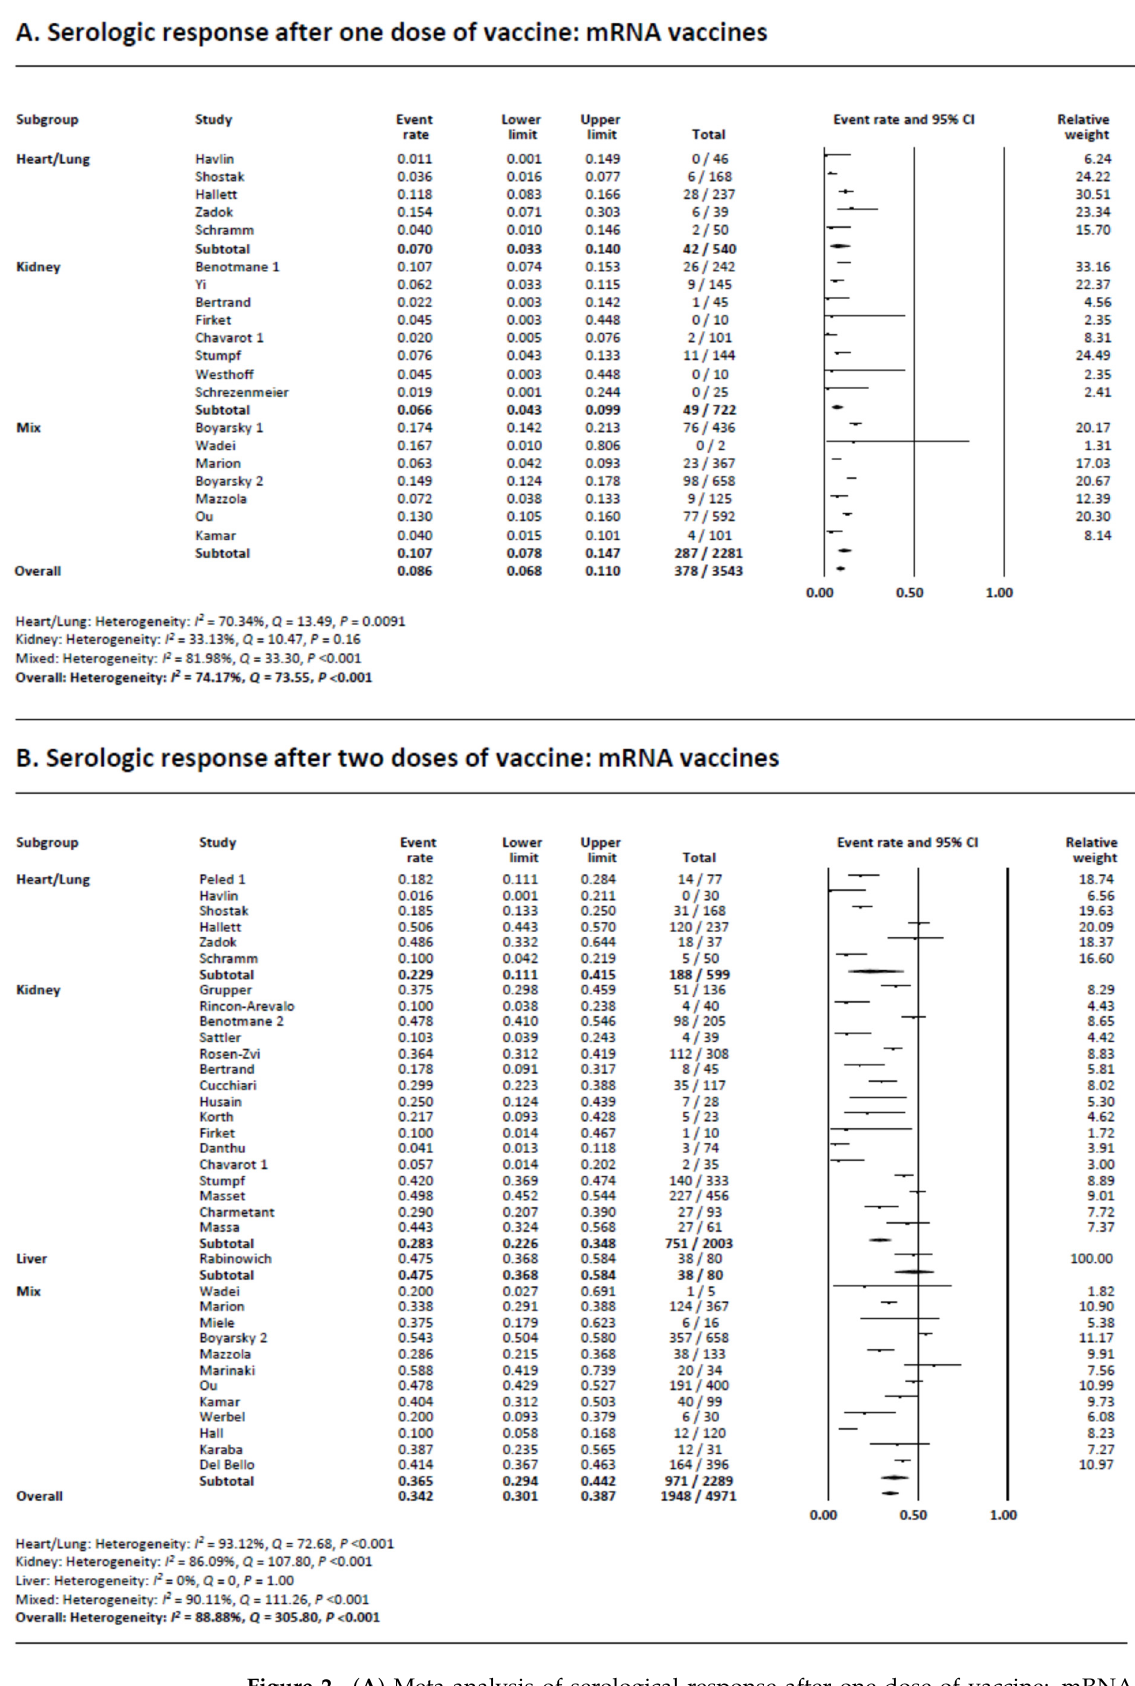
Figure 2. ( A ) Meta-analysis of serological response after one dose of vaccine: mRNA vaccines. ( B ) Meta-analysis of serological response after two doses of vaccine: mRNA vaccines.